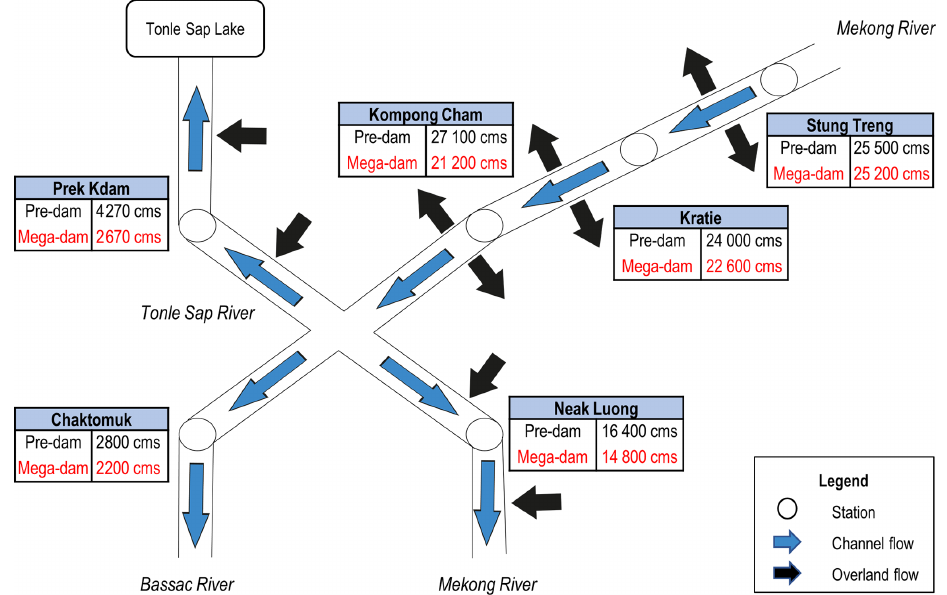
Figure 6. Schematic of wet-season discharge on the Cambodian floodplains during the pre-dam and mega-dam era. Across all stations, there is a reduction of discharge during the mega-dam era of 2010–2019.